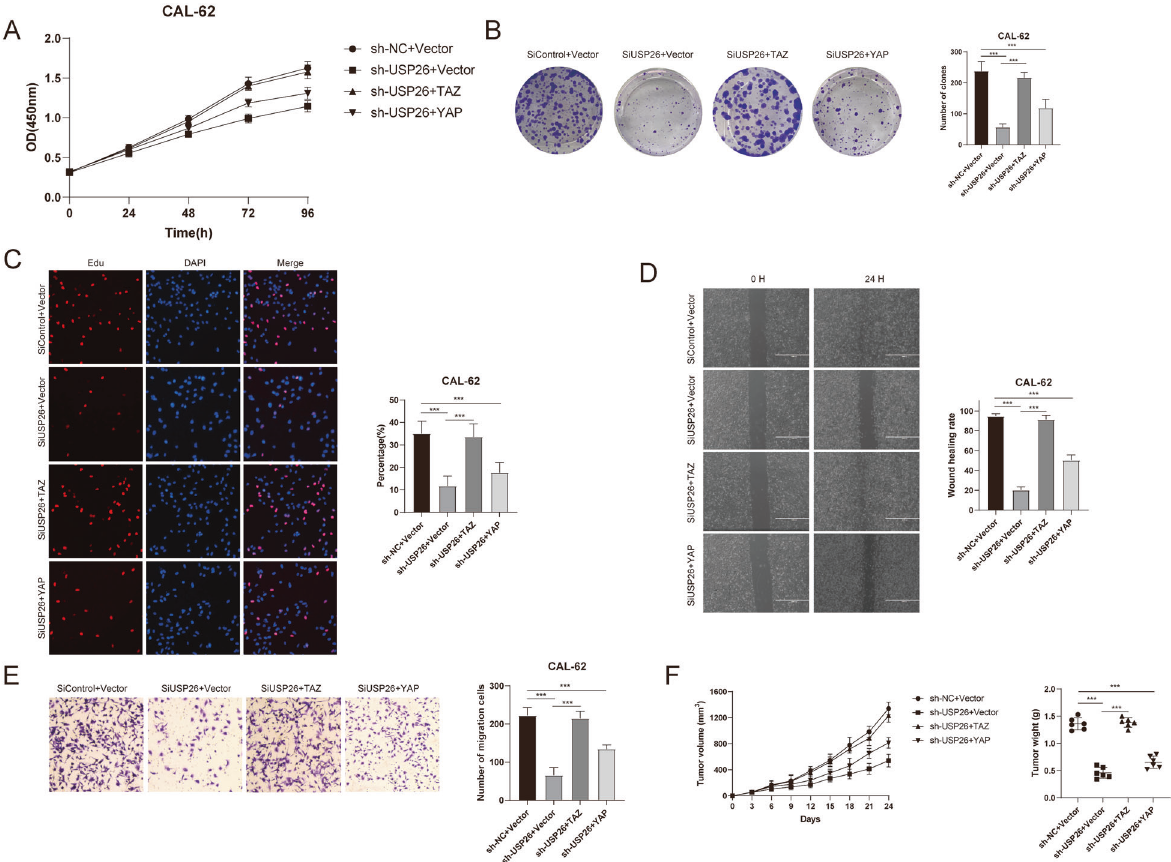
F Overexpression of TAZ in USP26-knockdown cells recovered tumor growth in vivo. G Overexpression of TAZ in USP26-knockdown cells recovered tumor metastasis in vivo. * P value < 0.05; ** P value < 0.01; *** P value <